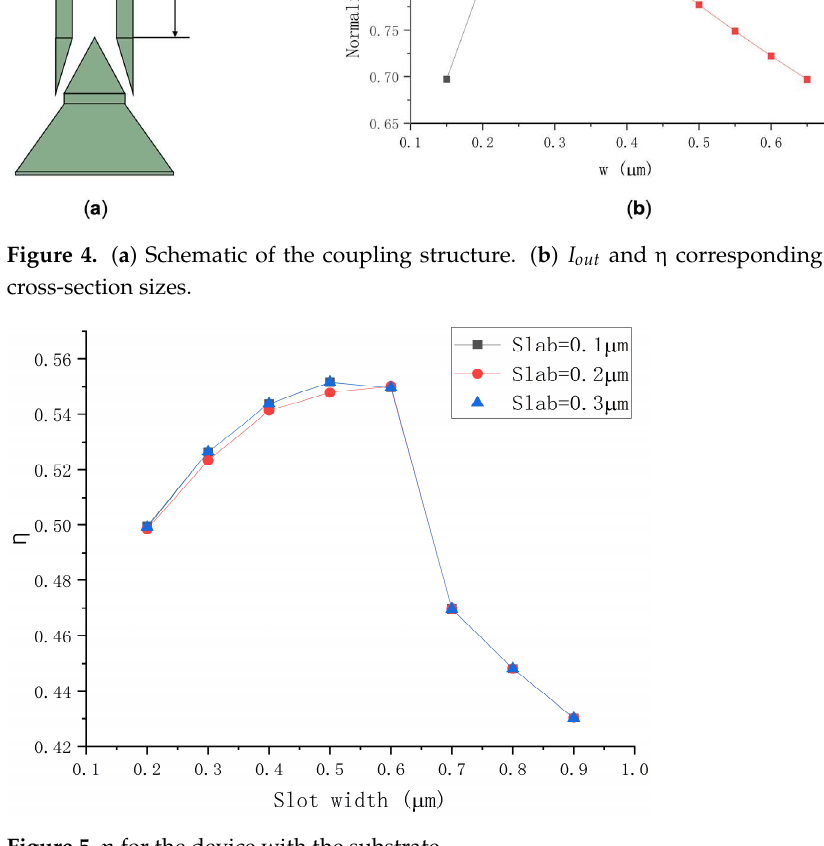
Figure 5. η for the device with the